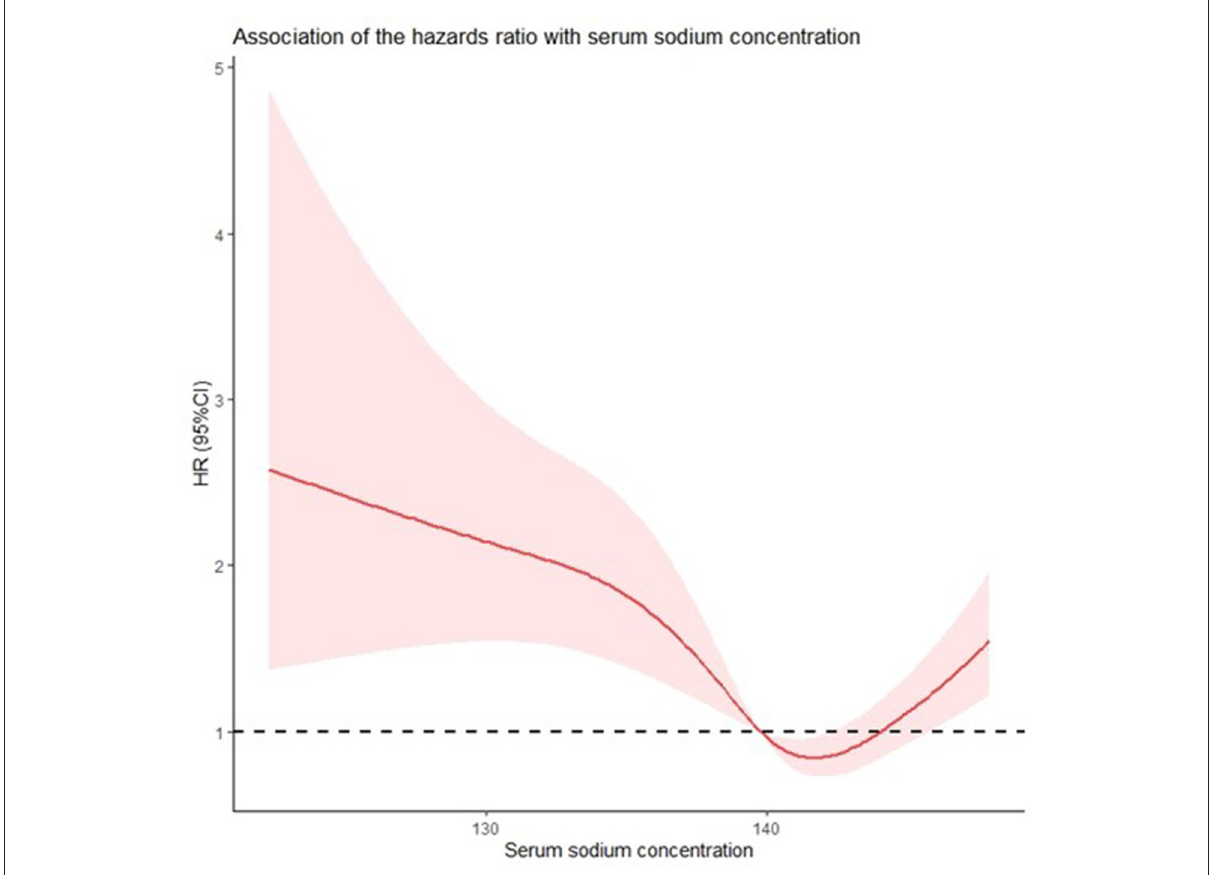
FIGURE3 Both hypo- and hypernatremia affect the all-cause mortality of patients with atrial fibrillation without heart failure in a serum sodium concentration-dependent manner. Restricted cubic spline curve (RCS) showing the unadjusted hazard ratios for all-cause mortality as a function of sodium concentration according to univariate Cox proportional hazards